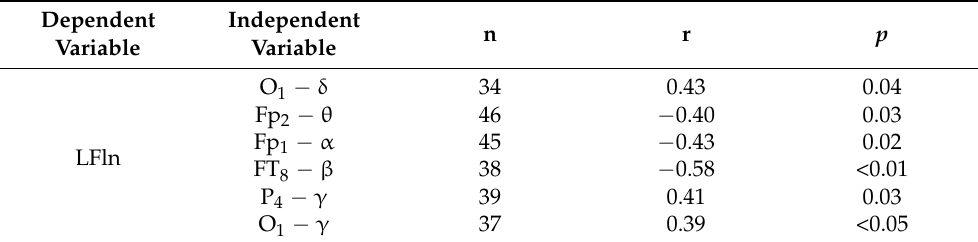
Table 1. Significant associations between electroencephalography variables and log transformed low frequency heart rate variability of train drivers.